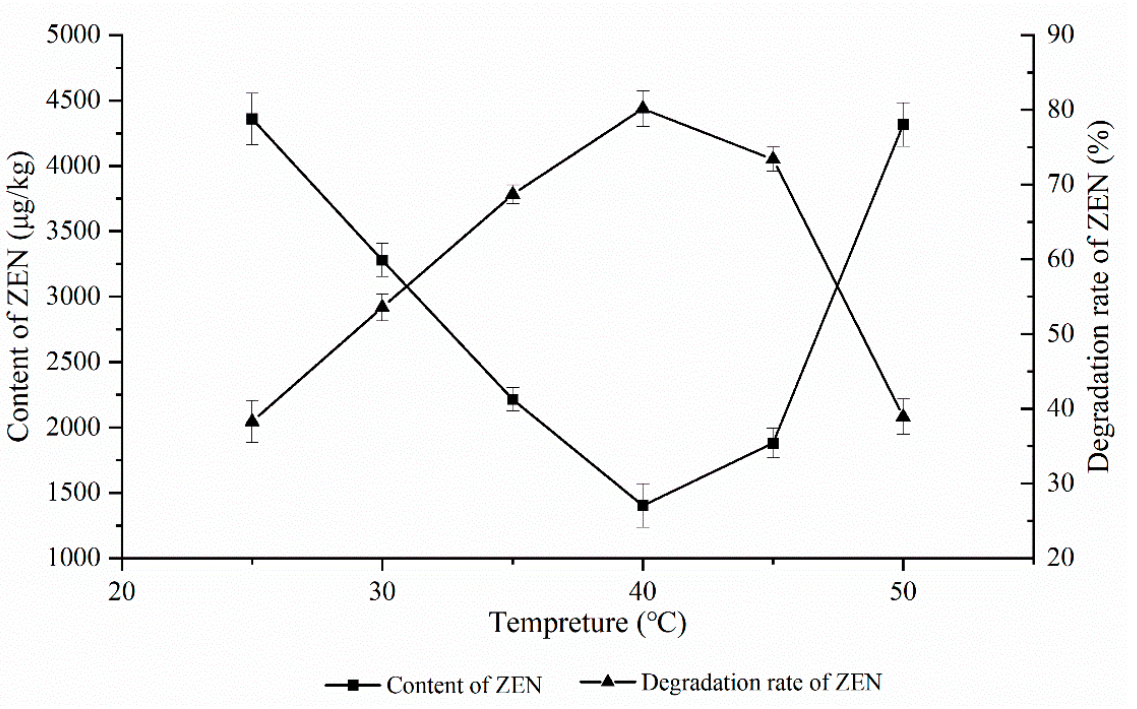
Figure 1. Effects of reaction temperature on the degradation of zearalenone.